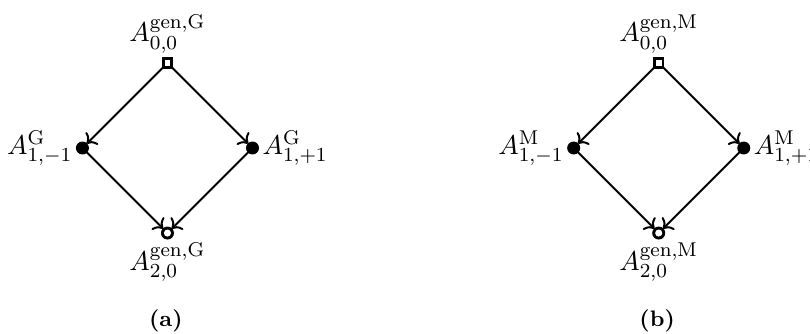
Figure 5. Goldstone (a) and memory (b) diamonds for the leading soft photon theorem.